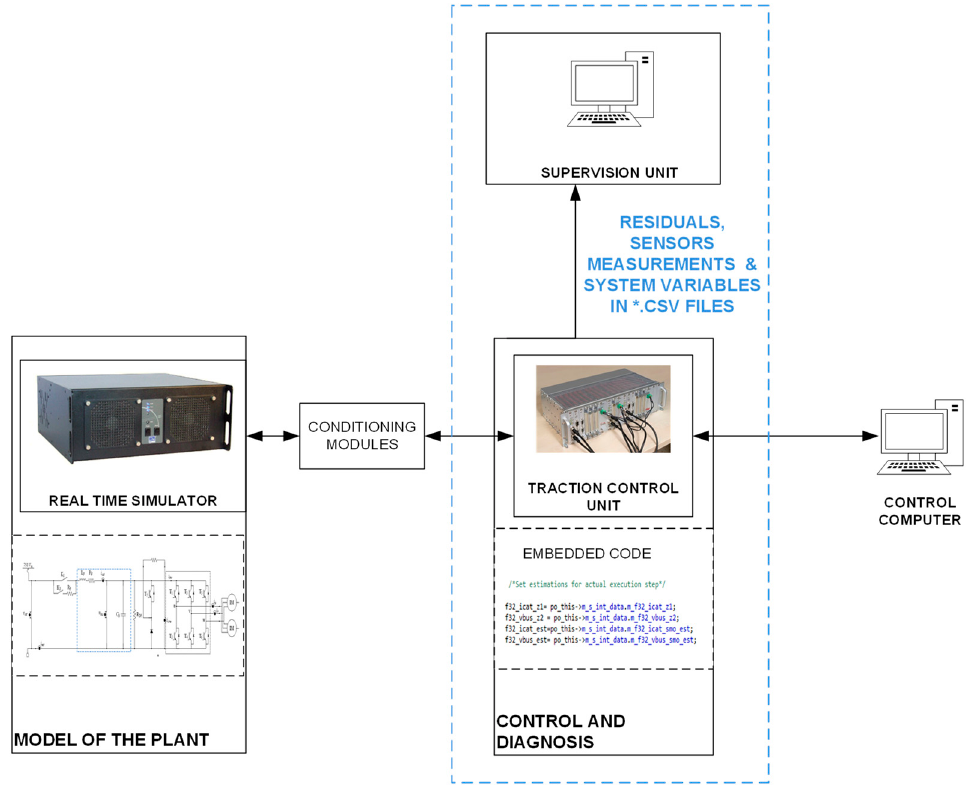
Figure 9. Hardware in the loop platform.